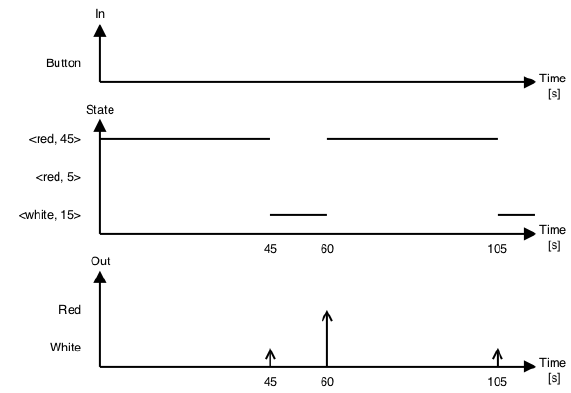
Figure 1: Trajectories of traffic light with no input